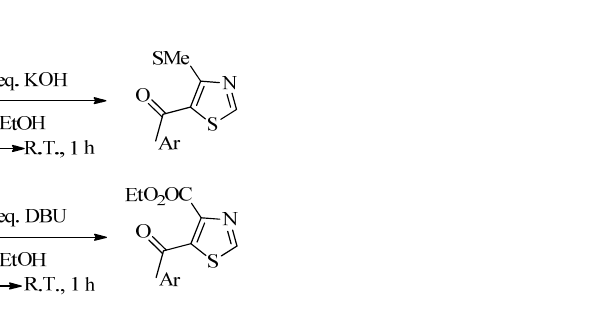
Scheme 13. Synthesis of substituted thiazoles via cyclization of tosylmethyl isocyanide with α -